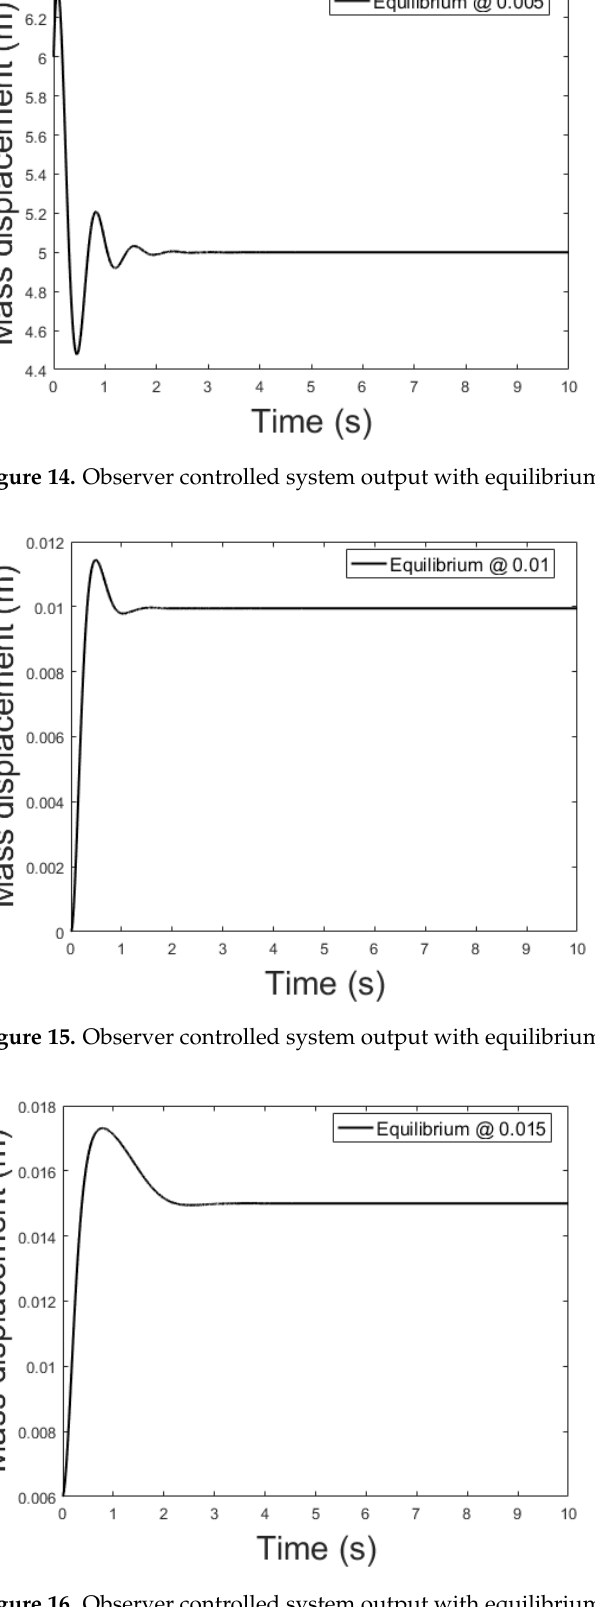
Figure 16. Observer controlled system output with equilibrium at x = 0.015.